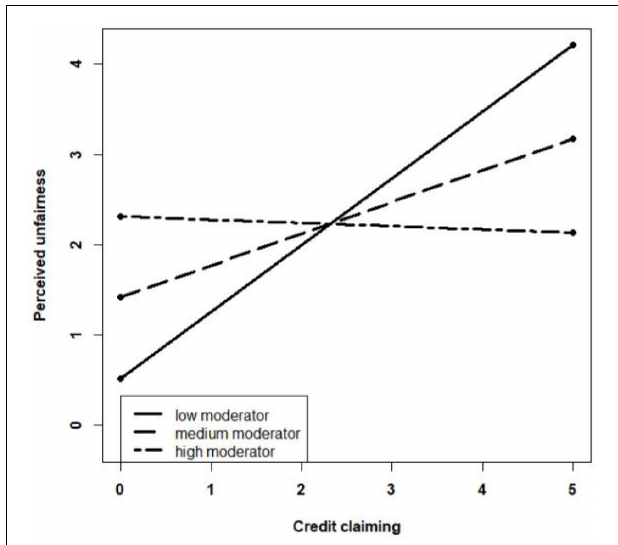
FIGURE 3 | Moderating effect of credit-claiming attribution to protect employees on the relationship between leaders’ credit claiming and employees’ perceived